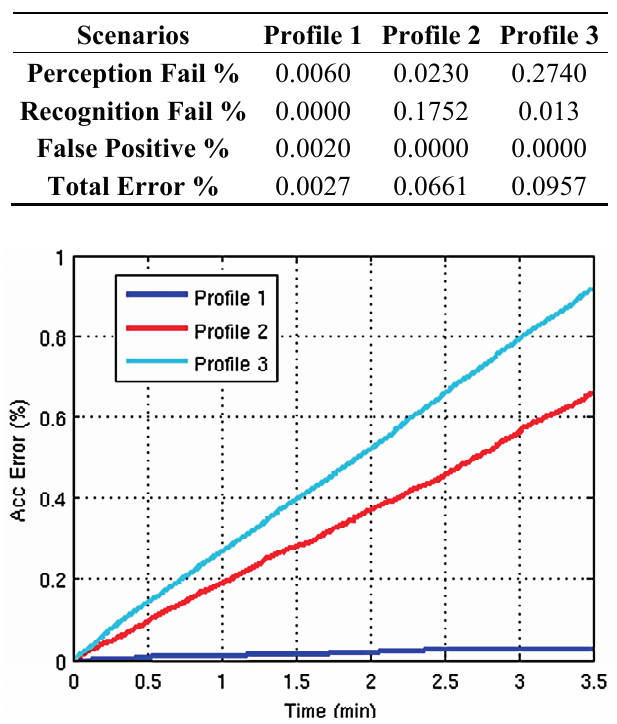
Figure 14. Accumulated